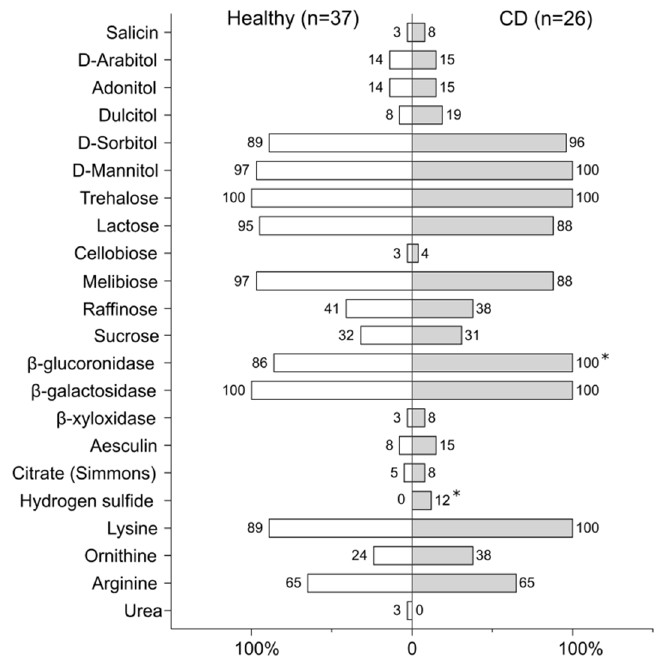
Figure 5. Distribution of biochemical features of E. coli strains from patients with Crohn’s disease and healthy individuals. Numbers indicate non-susceptible strains capable of utilizing corresponding carbohydrates (* p < 0.1, Fisher’s exact test).